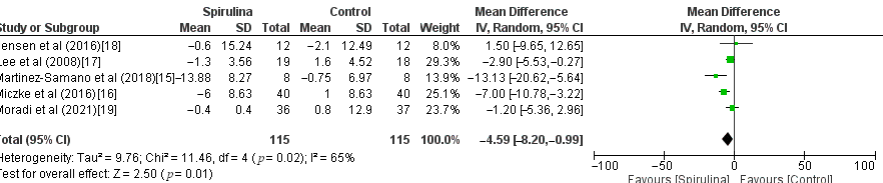
Figure 2. Risk of bias assessment for included randomized controlled trials (RCTs) [15–19].